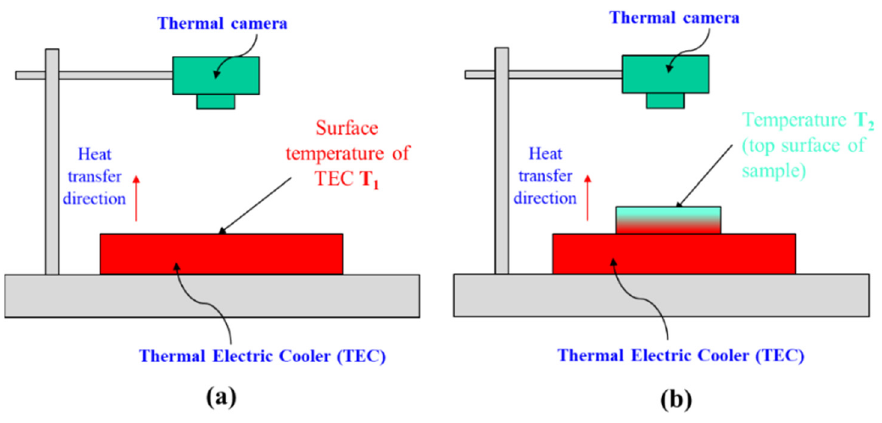
Figure 4. ( a ) Determination of temperature of bottom and ( b ) top surfaces of sample.